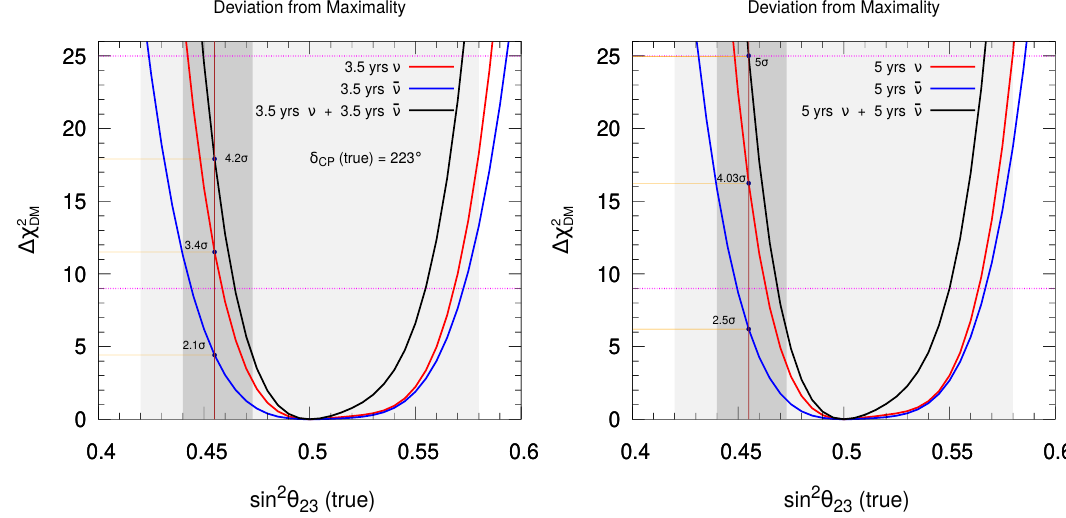
Figure 9 . Potential of DUNE to establish the deviation from maximal θ 23 as a function of true sin 2 θ assuming true NMO and δ (true) = 223 ◦ . The red, blue, and black curves in the left 23 CP (right) panel are drawn assuming 3.5 (5) years of neutrino run, 3.5 (5) years of antineutrino run, and the combined 7 (10) years of ν + ¯ ν run, respectively. In the fit, we marginalize over the current 3 σ range of ∆ m 2 and δ , while keeping rest of the oscillation parameters fixed at their present CP 31 best-fit values as shown in table 1. The dark (light)-shaded grey area shows the currently allowed 1 σ (2 σ ) region in sin 2 θ as obtained in the global fit study [11] assuming NMO with the best-fit value 23 of sin 2 θ = 0 . 455 as shown by vertical brown line. The horizontal orange lines show the sensitivity 23 (experessed in σ = p ∆ χ 2 ) due to individual runs for the current best-fit value of sin 2 θ . The 23 DM capability of DUNE to establish non-maximal θ at 3 σ ( ∆ χ 2 = 9 ) and 5 σ ( ∆ χ 2 = 25 ) confidence 23 DM DM levels are shown by horizontal pink dotted